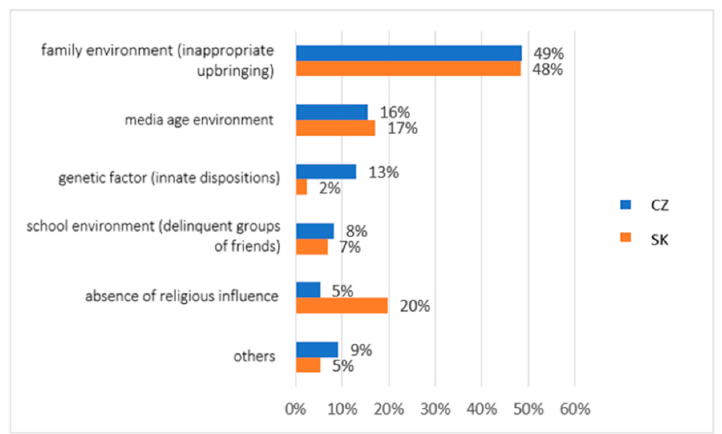
Figure 3. Descriptive statistics of the participants’ subjective perception of the reason for people’s deviant behaviour (comparison of the healthy population of eastern Slovakia and north-western Czech Republic). Legend: CZ—healthy population of north-western Czech Republic, SK—healthy population of eastern Slovakia. Source: own